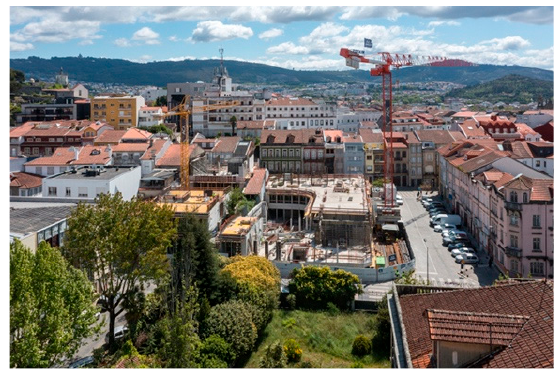
Figure 16. Building at Braga. ©João Ferrand.